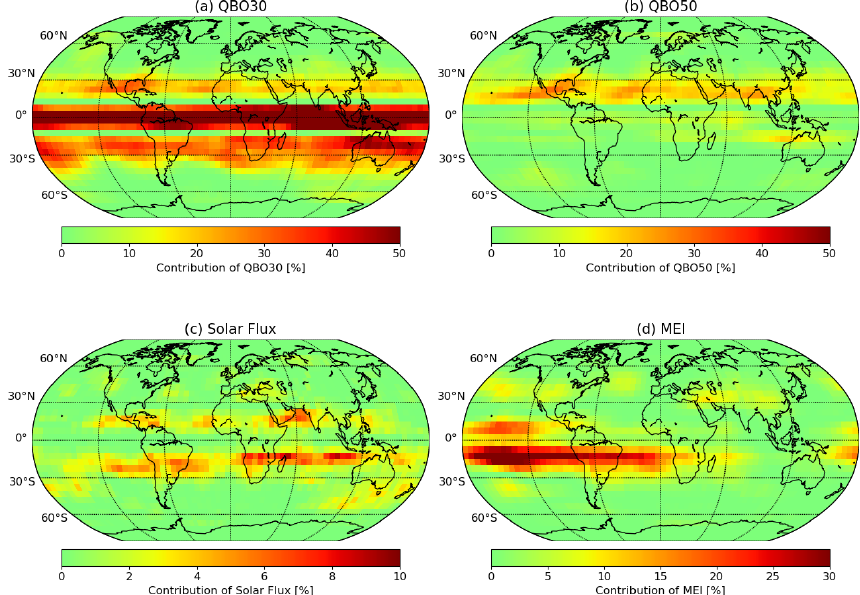
Figure A2. Contributions of the individual explanatory variables (a) QBO30, (b) QBO50, (c) solar flux, and (d) MEI to ozone variability, expressed in